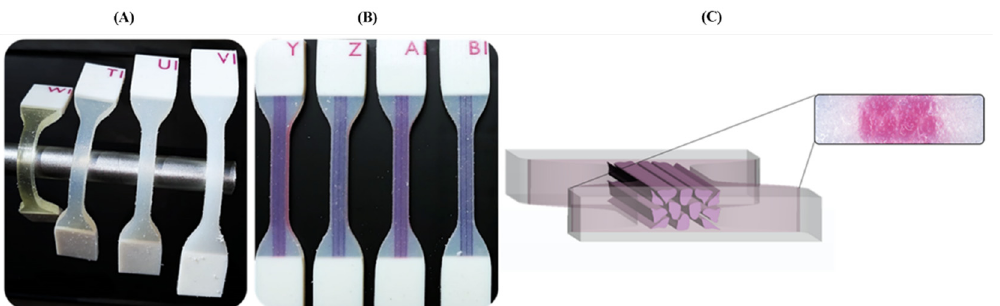
Figure 2. Three-dimensional printed dog-bone specimens of the different base PolyJet materials and the proposed biomimetic patterns. ( A ) Comparison of the different durometers’ levels of the Agilus30™ and TissueMatrix™ materials. ( B ) The specimens with the different embedded patterns are shown. The test piece combines the rigid (VeroWhite™) and flexible (Agilus30™) materials. ( C ) A cross-section of the Tendon-Mimic (TM) specimen is shown in a microscope view at 100× magnification.